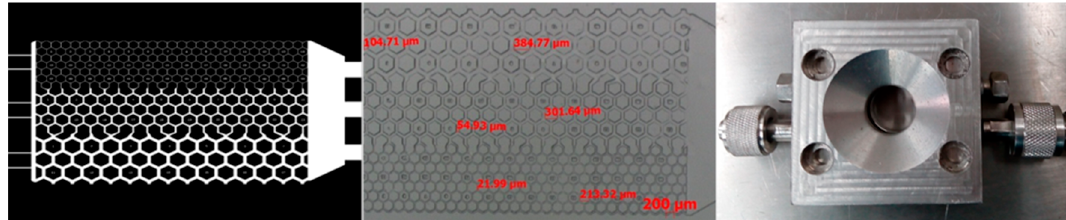
Figure 2. Glass etched micromodel and its holder.